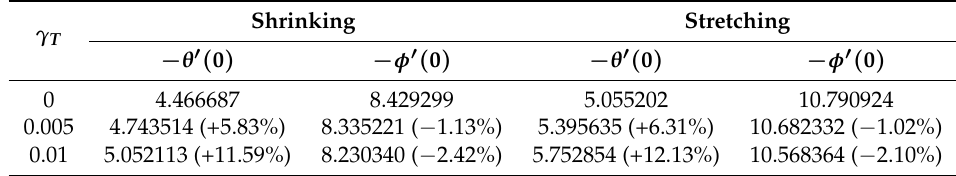
Table 3. Numerical values of − θ (cid:48) ( 0 ) and − φ (cid:48) ( 0 ) for the case of dual stratified nanofluid over shrinking sheet ( ε = − 1 ) and stretching sheet ( ε = 1 ) when M = Le = 1, λ = − 0.5, N = 0.5, S = 2.3, Pr =